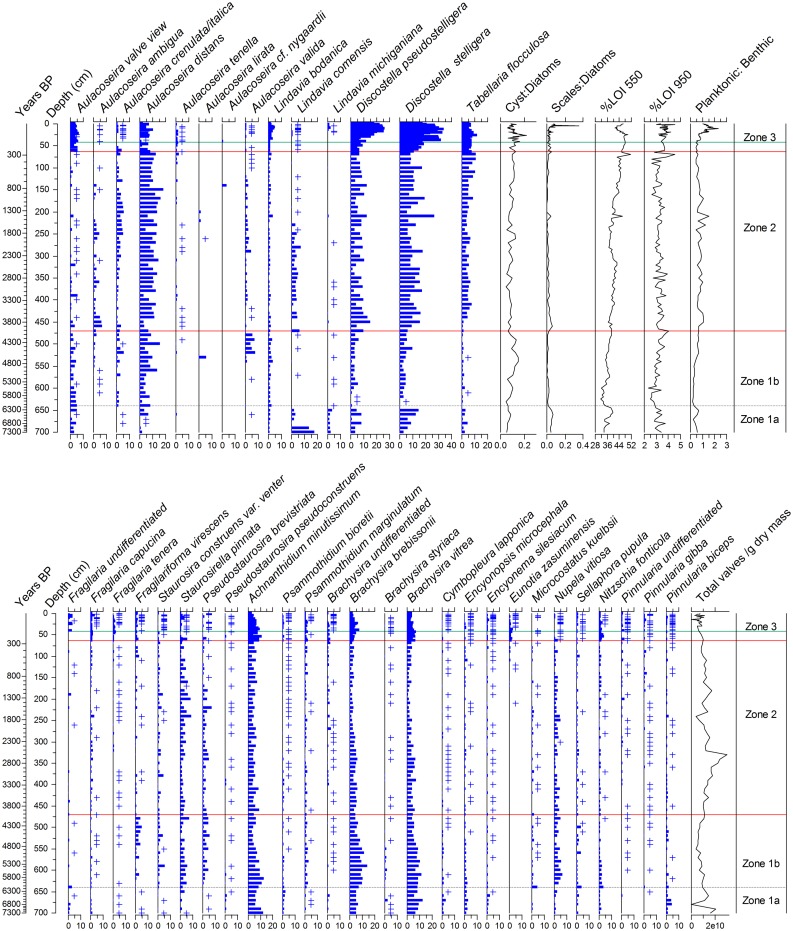
Holocene diatom stratigraphy for Wishart Lake.Diatom species are displayed in percent abundance. Only taxa appearing at >2.5% abundance in any one sample are plotted out of a total of 280 taxa recorded. Sample points where rare taxa appear at <0.5% abundance are displayed by the + symbol. Three significant zones were delineated using cluster analysis (solid red lines, with the dashed grey line separating Zone 1 into two sub-zones). The solid green line in the upper zone indicates the Ambrosia rise. The age axis is in calibrated, calendar years BP where year -61 is the time of core collection (2011 AD). Full diatom counts are available at neotomadb.org (Dataset ID = 19788; http://apps.neotomadb.org/Explorer/?datasetid=19788). Diagram plotted using C2 [64].